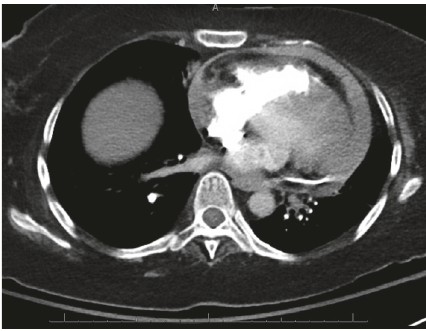
Figure 1: CT scan transverse view with hyperdense pericardial effusion.